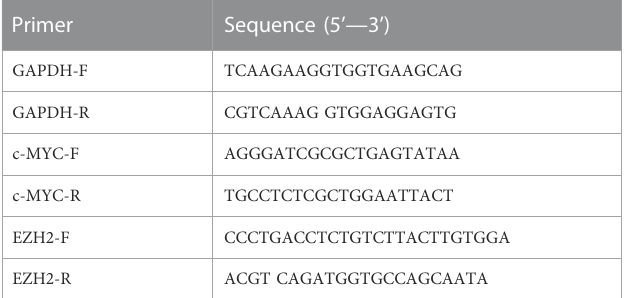
TABLE 1 The data sets collected from public GDSC